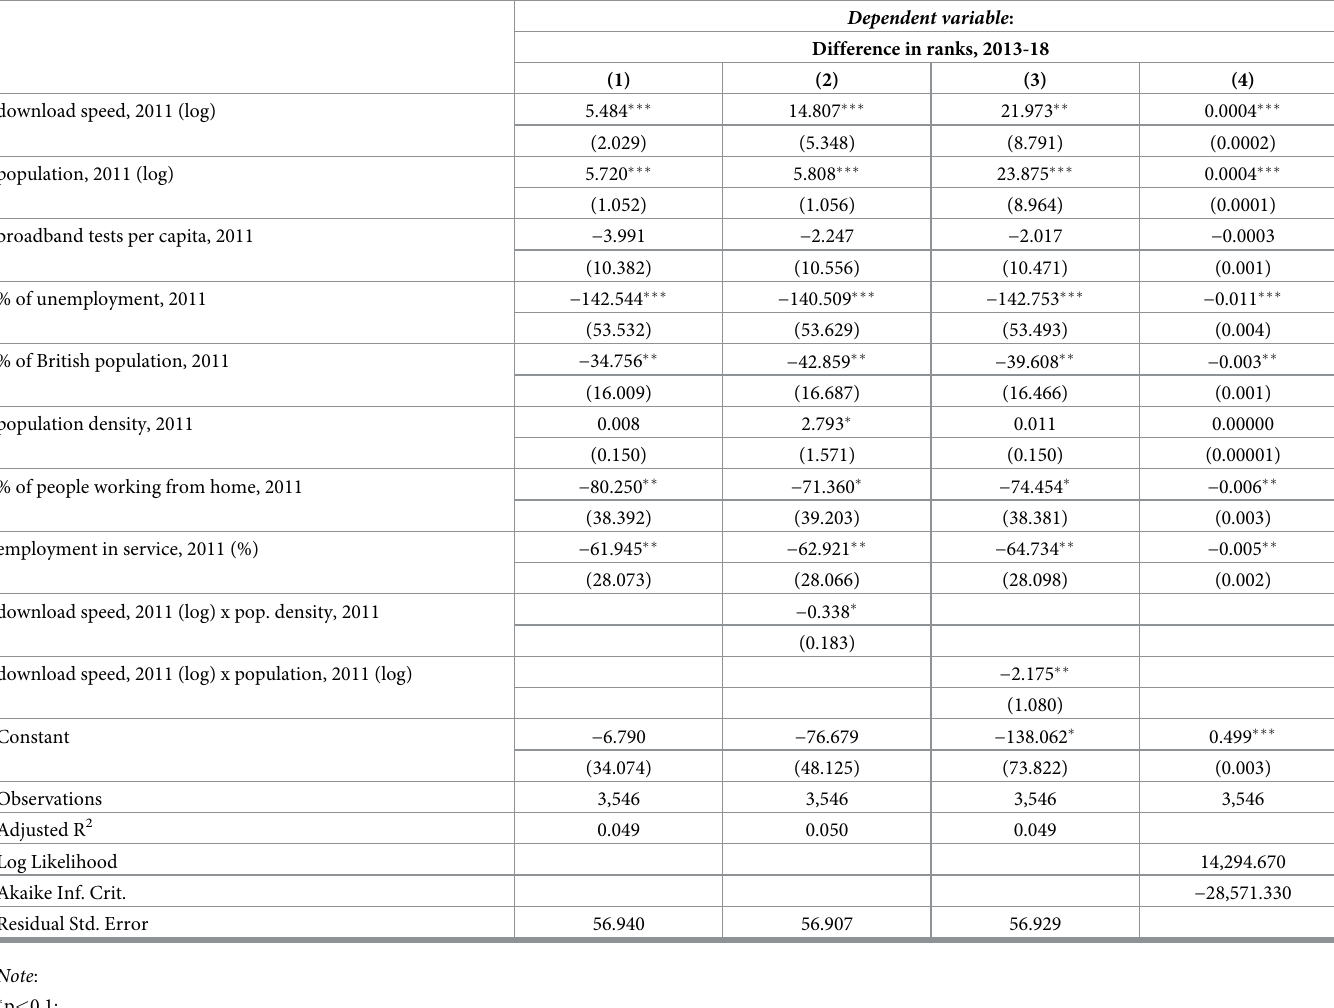
Table 10. OLS and GLM estimations of Eq (4) for the